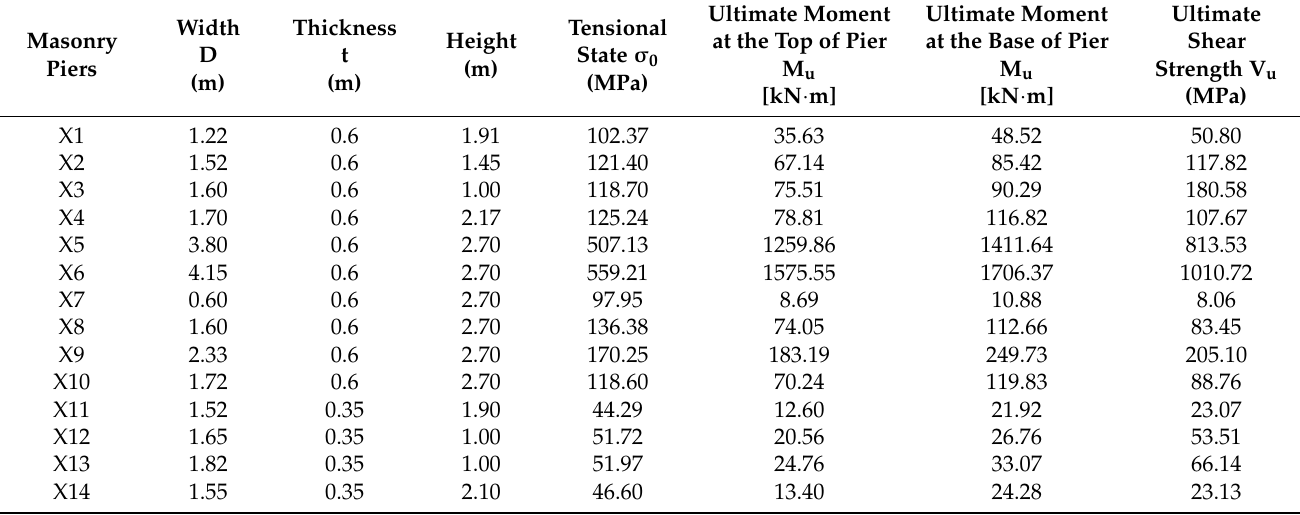
Table A1. Geometrical and mechanical parameters of masonry